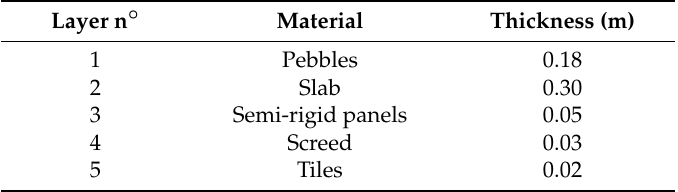
Table 2. Baseline building: Ground floor composition, from the external to the internal layer.